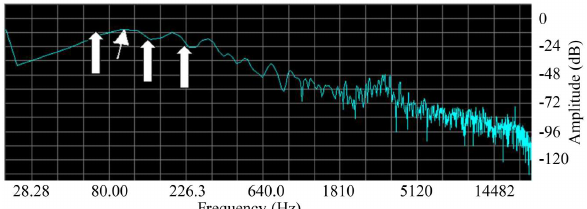
Fig. 6. Detailed view of the low part of the spectrum from the Fig. 8. Window size: 2048 samples, windowing type: Blackmann-Harris